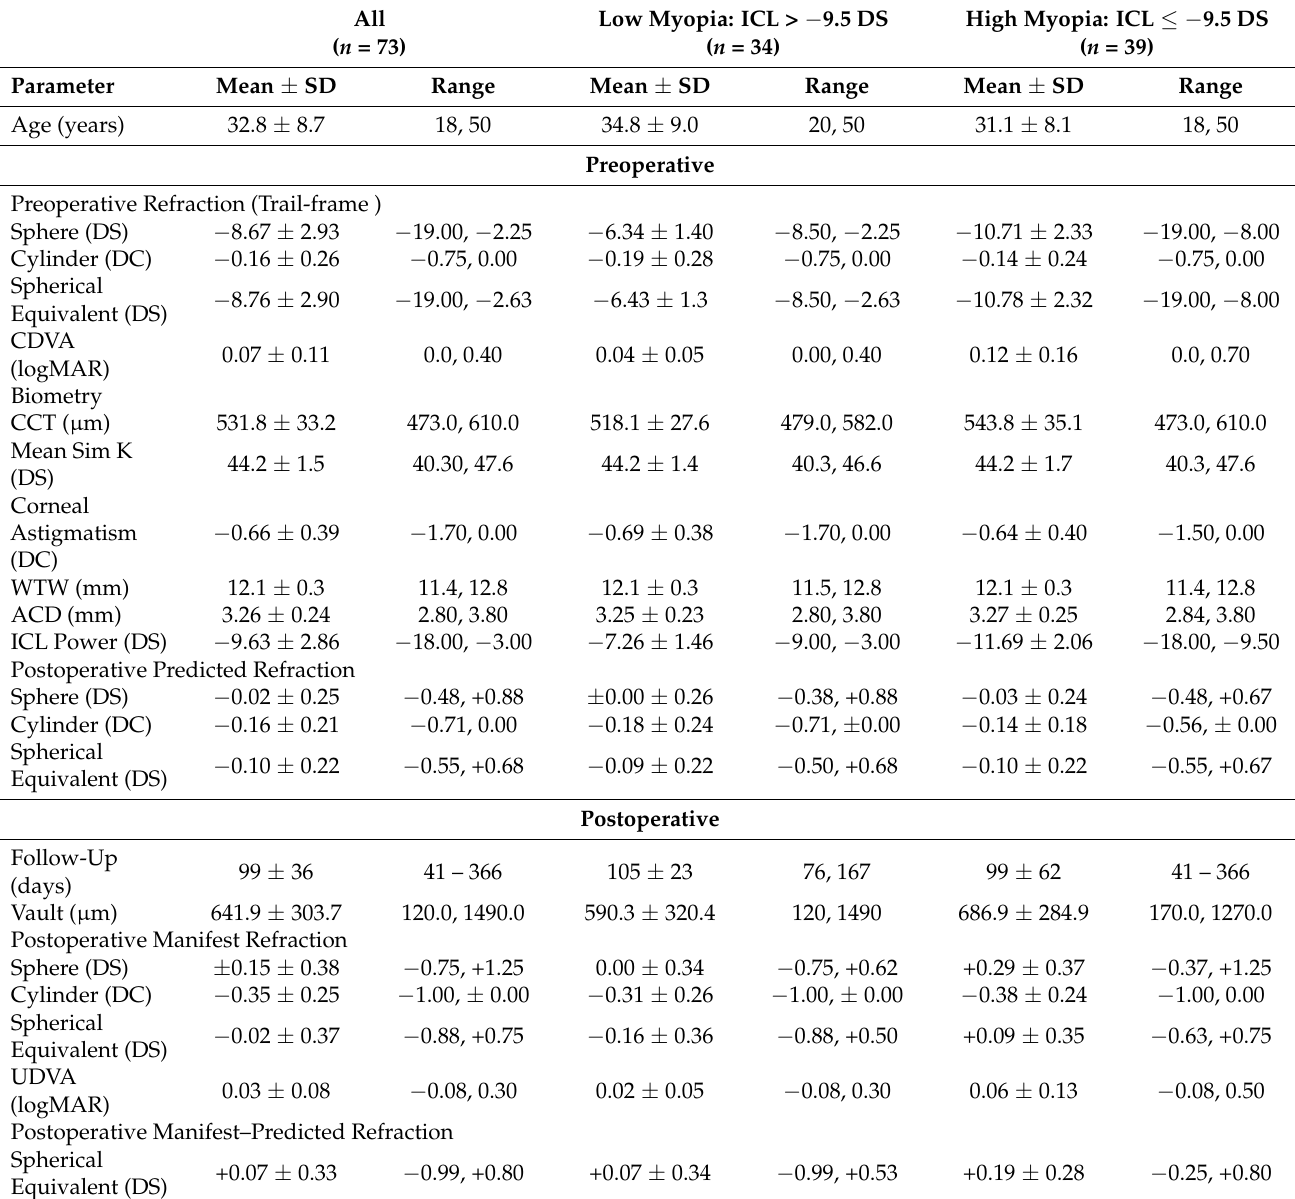
Table 2. Pre- and postoperative refractive and anatomical data. Values are represented by the mean, standard deviation (SD) and range; corrected distance VA (CDVA), central corneal thickness (CCT), internal anterior chamber depth (ACD), white-to-white distance (WTW), and uncorrected distance VA (UDVA).